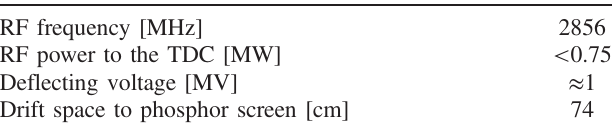
TABLE II. Parameters of the